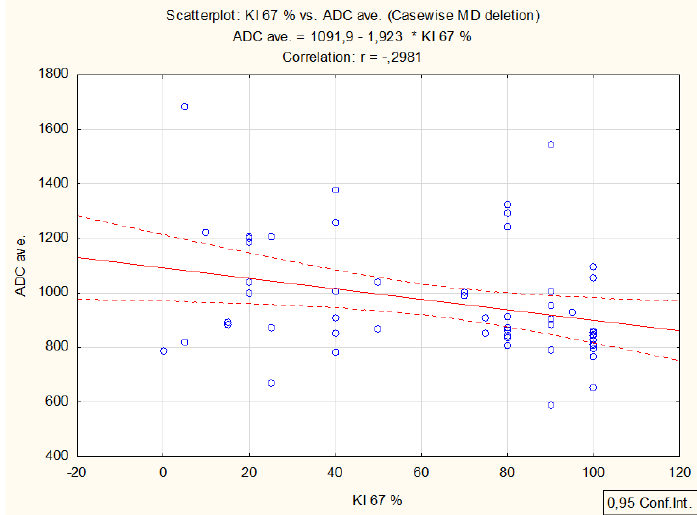
Figure 7. Correlation between Ki67 expression and mean ADC ( p = 0.027).